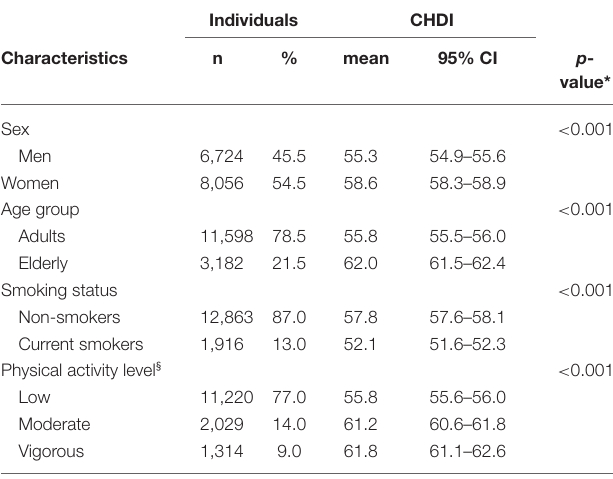
TABLE 3 | Characteristics of the individuals included in the study and their Cardiovascular Health Diet Index scores. ELSA-Brasil, 2008–2010. Individuals CHDI